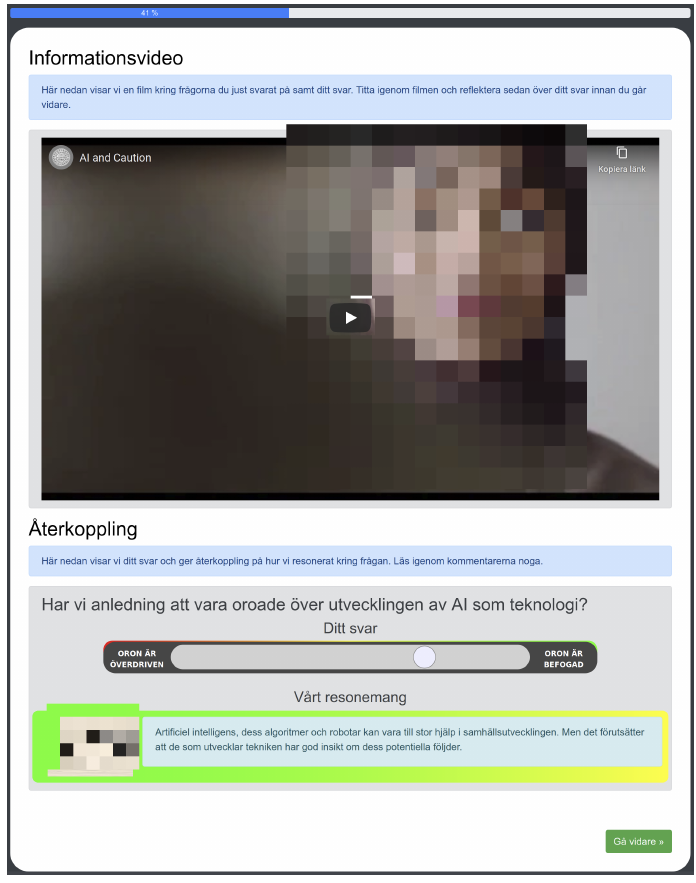
Figure 6. Screenshot of the feedback setup for the distraction task of Experiment